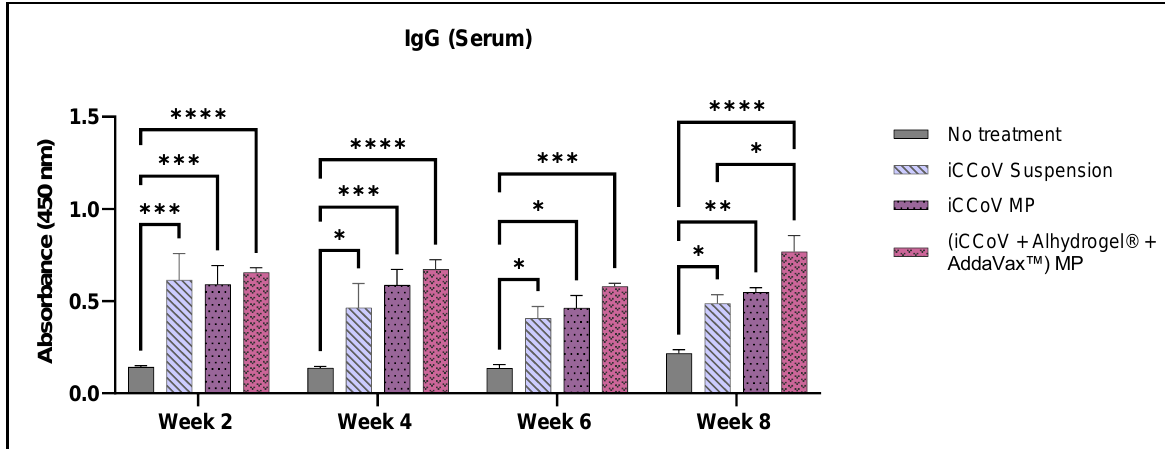
Figure 9. Assessment of serum IgG antibody levels in mice. (Absorbance at 450 nm). Responses obtained are compared to the naïve group (No treatment control) and the iCCoV suspension group. Data are expressed as mean ± SEM, n = 4 mice, Two-way ANOVA, Post hoc Tukey’s multiple comparisons test. ns, non-significant, * p ≤ 0.05, ** p ≤ 0.01, *** p ≤ 0.001, **** p ≤ 0.0001.